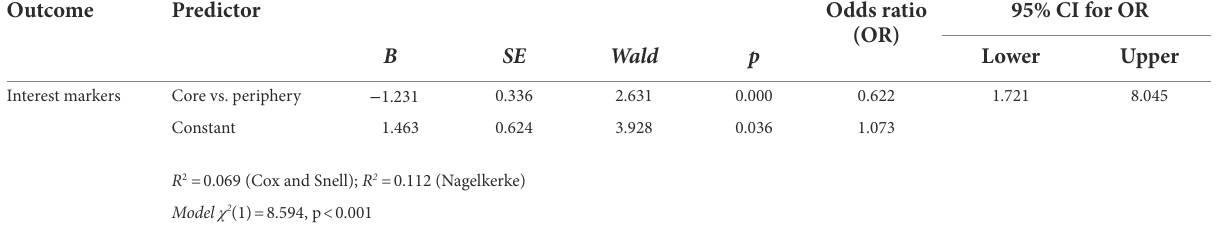
TABLE 3 Results of binary logistic regression on the overall use of interest markers.